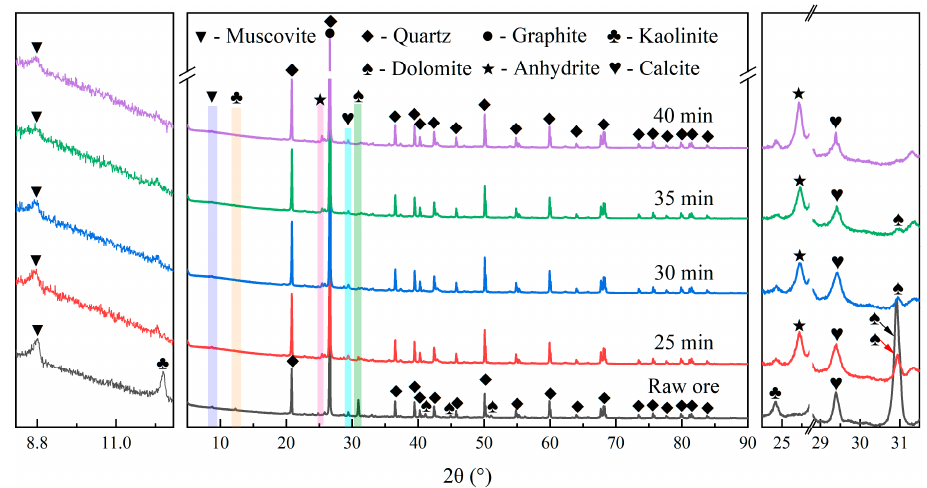
Figure 10. XRD patterns of the pre-roasting products.